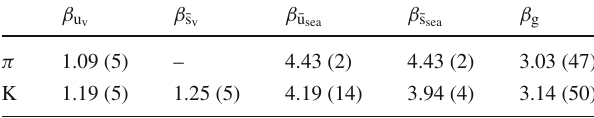
Table 4 Comparisons of our predicted moments (cid:6) x (cid:7) , valence quark distribution of the pion with some other theoretical cal- culations, at Q 2 = 4 , 10 , 27 GeV 2 . The errors in the table indicate the